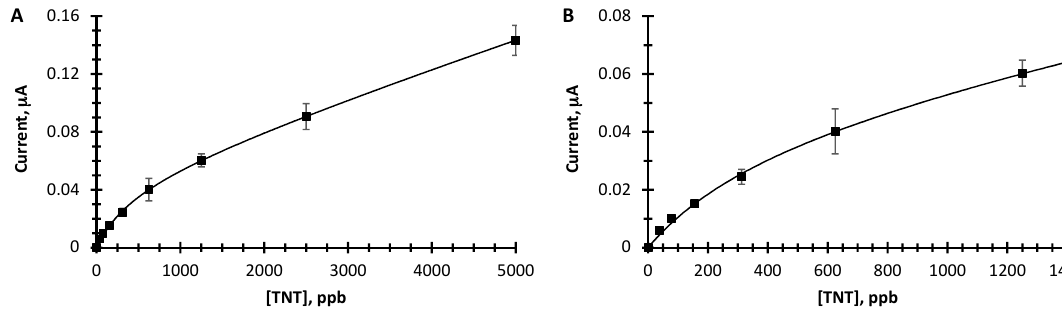
Figure 5. Dose response curves for oxygen functionalized epitaxial graphene. ( A ) Net peak amplitude, I pc vs. {TNT}, for high ppb range; ( B ) Net peak amplitude vs. {TNT} for low concentration. The line is a least squares fit of the data to Equation 1 with a = 0.047, b = 3.7, K a = 0.05 µM − 1 , K b = 1.3 × 10 − 4 µM − 1 , (K units has been converted to µM − 1 ) range.